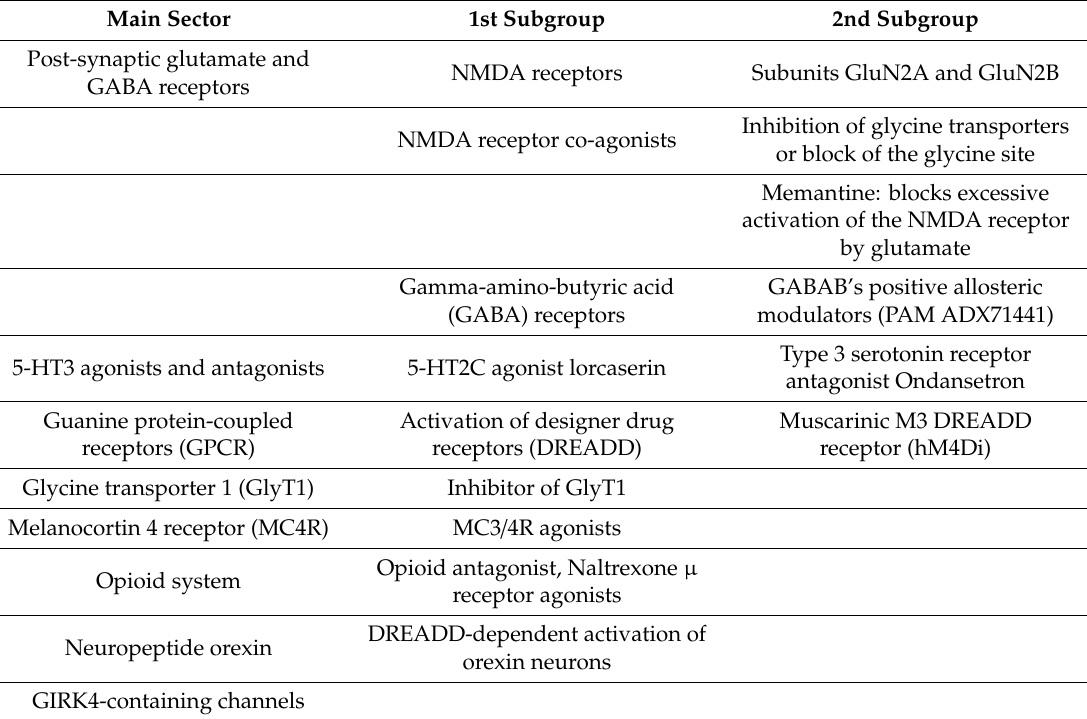
Table 1. Potential sites of attack for pharmaceutical therapy of obesity (for details and references please see